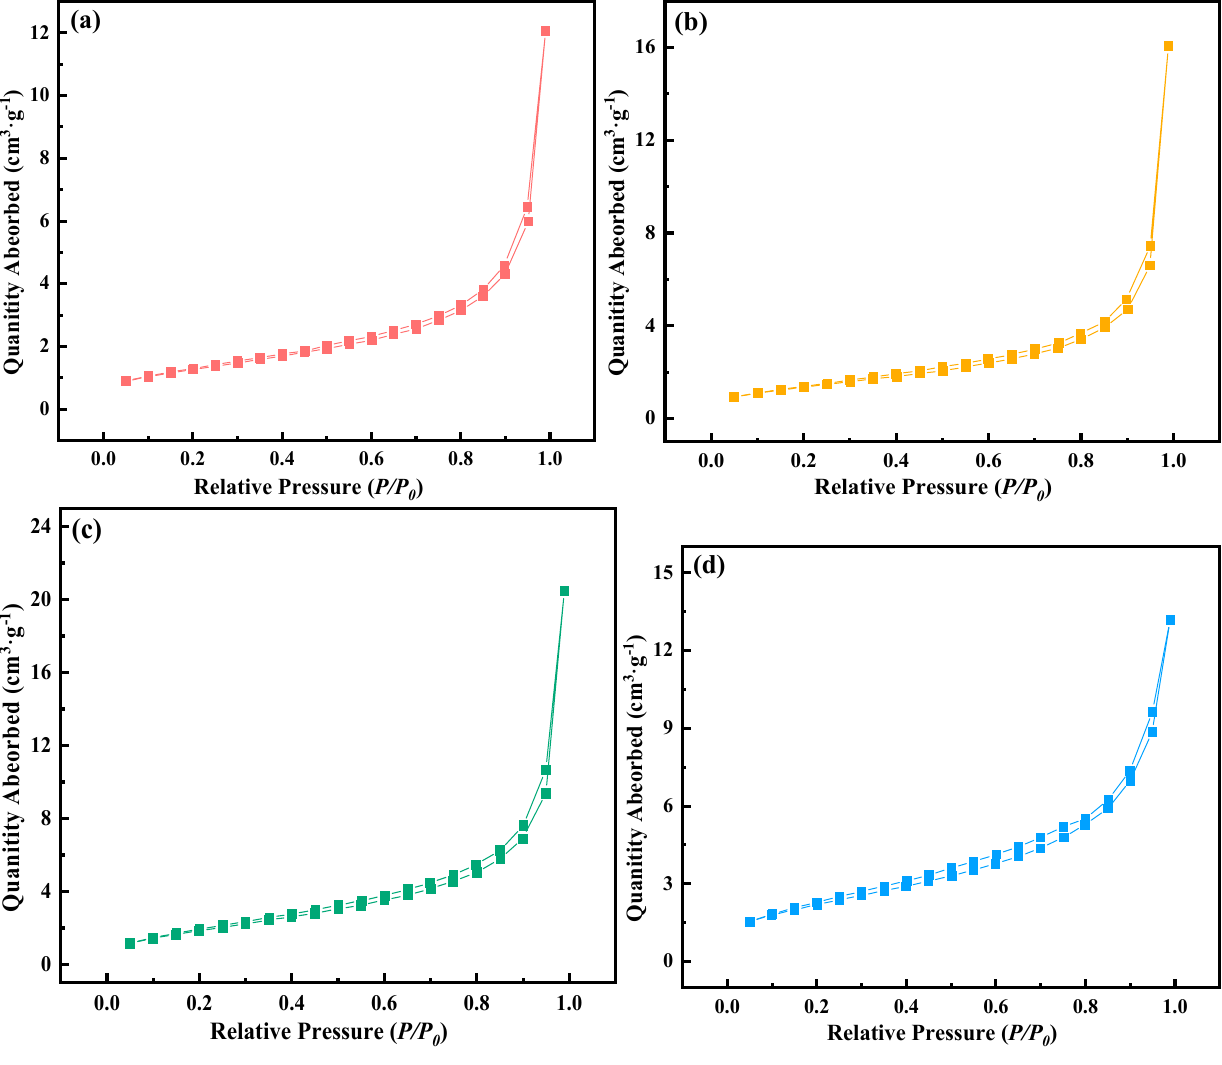
Figure 1. Isothermal curves of mixed oxides after different ball-milling times. (( a ) 8 h, ( b ) 10 h, ( c ) 12 h, ( d ) 14 h)